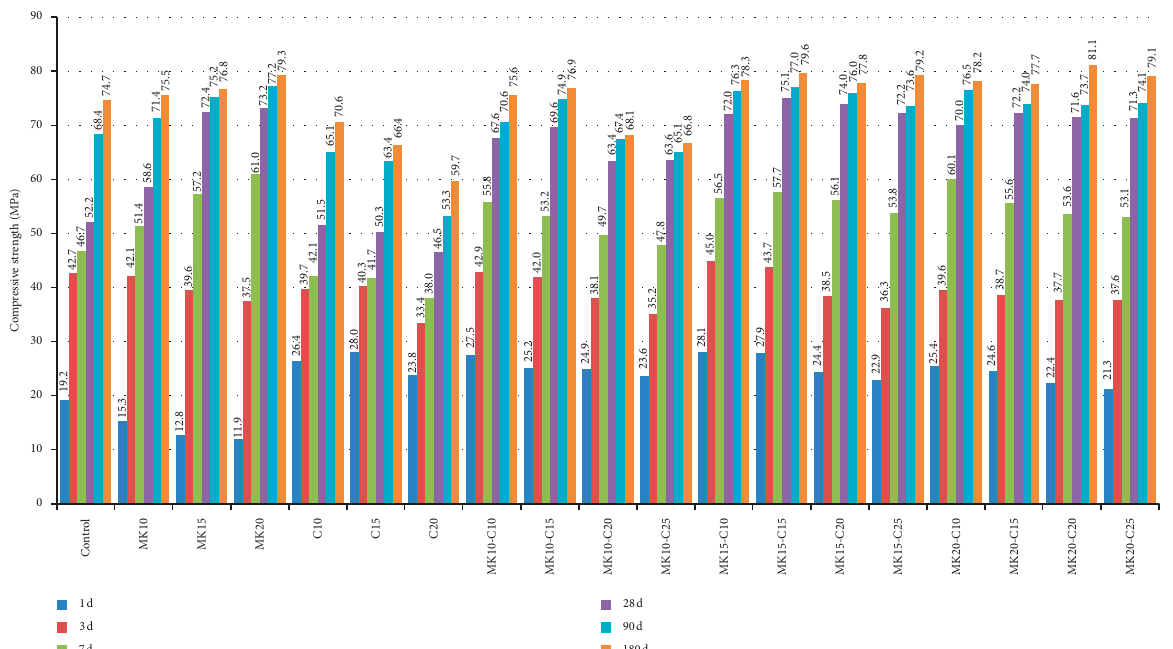
Figure 2: Compressive strength of all concretes produced at different curing times.